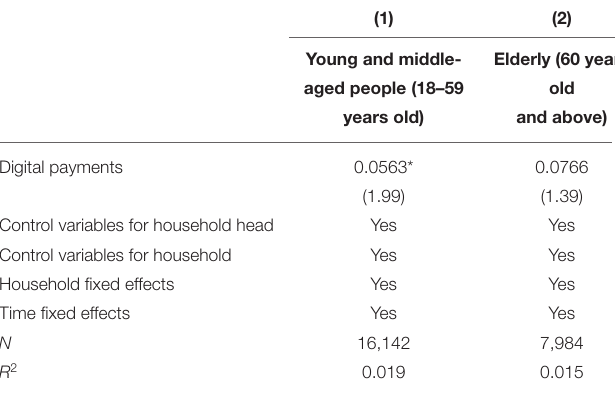
TABLE 10 | Heterogeneity in the age of household heads.